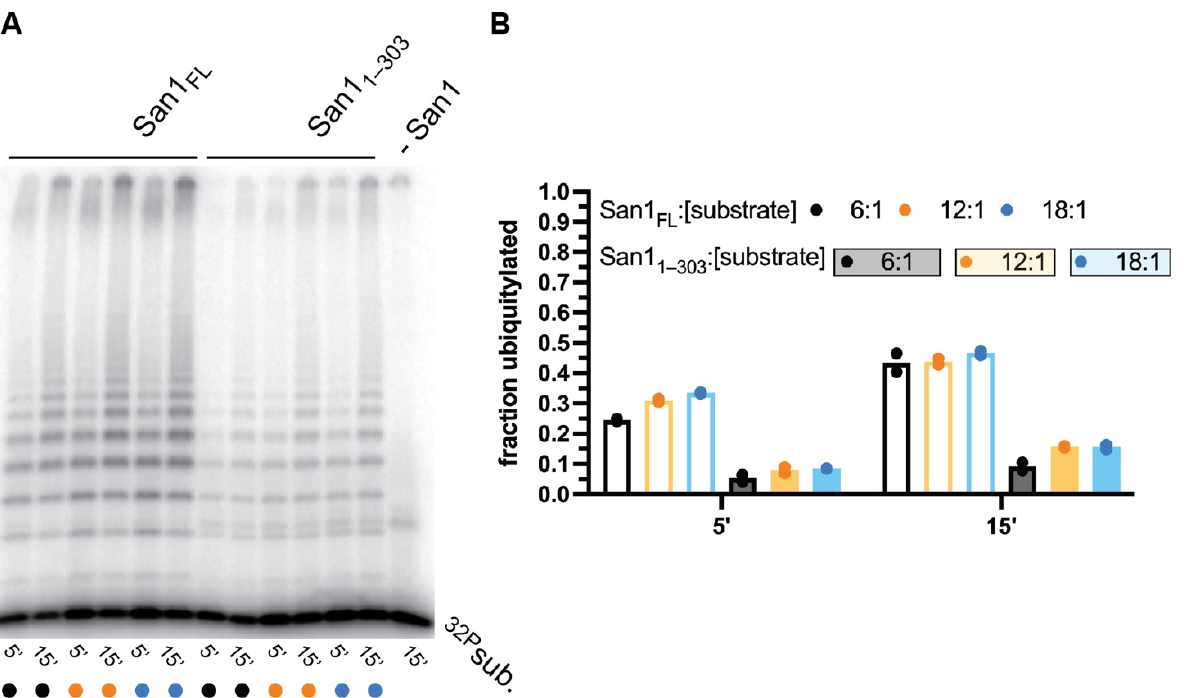
Figure 3. Similar fractions of peptide substrate are converted to ubiquitylated product by either full-length San1 or San1 1–303 over a wide range of substrate levels. ( A ) Representative autoradiogram of multi-turnover ubiquitylation reactions containing substrate to San1 ratios of 6:1 (lanes 1–2 for full-length; lanes 7–8 for San1 1–303 ), 12:1 (lanes 3–4 for full-length; lanes 9–10 for San1 1–303 ), or 18:1 (lanes 5–6 for full-length; lanes 11–12 for San1 1–303 ). The rightmost lane is a negative control reaction containing all necessary components for substrate ubiquitylation except San1. ( B ) Graph showing the fraction of substrate from ( A ) that had been converted to ubiquitylated products containing one or more ubiquitins. The results show duplicate data points from technical experimental replicates.